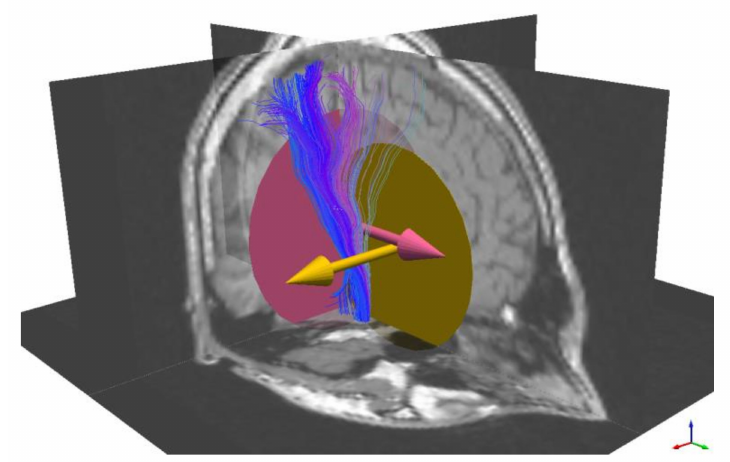
Figure A4. Definition of exemplary two exclude regions (2D circles) for initial refinement of the CST tractography results to eliminate fibers connecting to the cerebellum (pink ROI) and fibers crossing to the other hemisphere (yellow